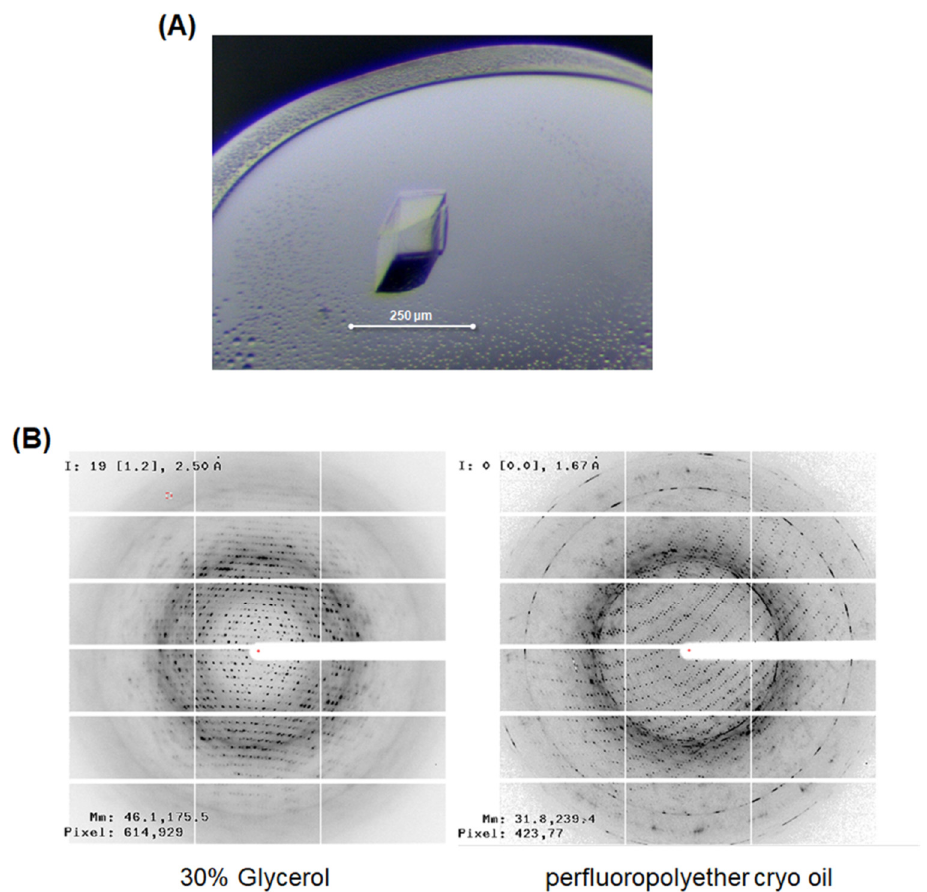
Figure 3. X-ray crystallographic study of Lg EstI. ( A ) Crystal of Lg EstI protein grown in 0.1 M Tris-HCl (pH 7.1), 0.2 M calcium acetate hydrate, and 19% ( w / v ) PEG 3000. ( B ) Cryoprotectant optimization for the X-ray diffraction study. Lg EstI crystals soaked in solutions containing perfluoropolyether cryo-oil for 10 s and flash-frozen under a nitrogen stream are shown ( right ).